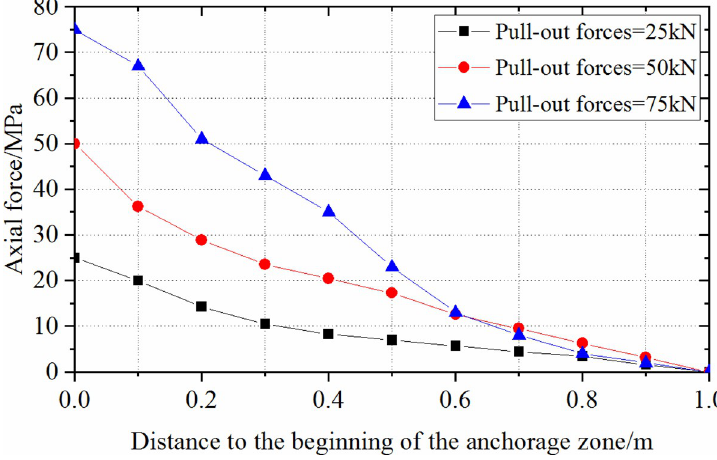
Fig 11. Axial force distributions of anchorage zone under different pull-out forces in laboratory test.